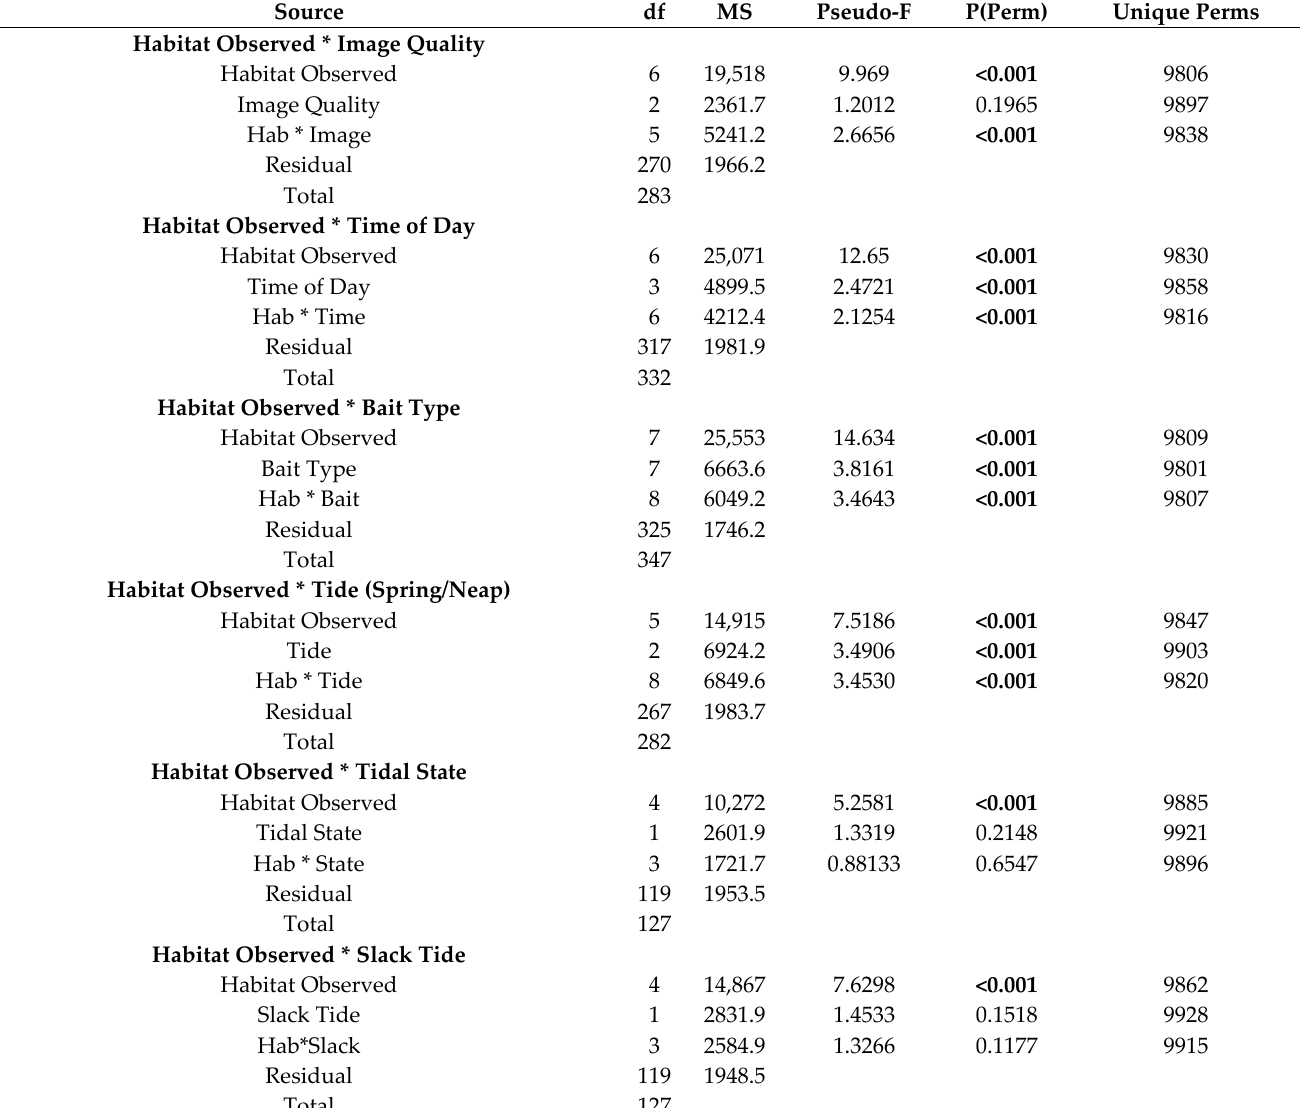
Table 4. PERMANOVAs for faunal assemblage composition assessing the influence of the six categorical predictors during BRUV deployments and their interaction with habitat observed. * Note N/A has been excluded from this statistical analysis Bold values p ≤